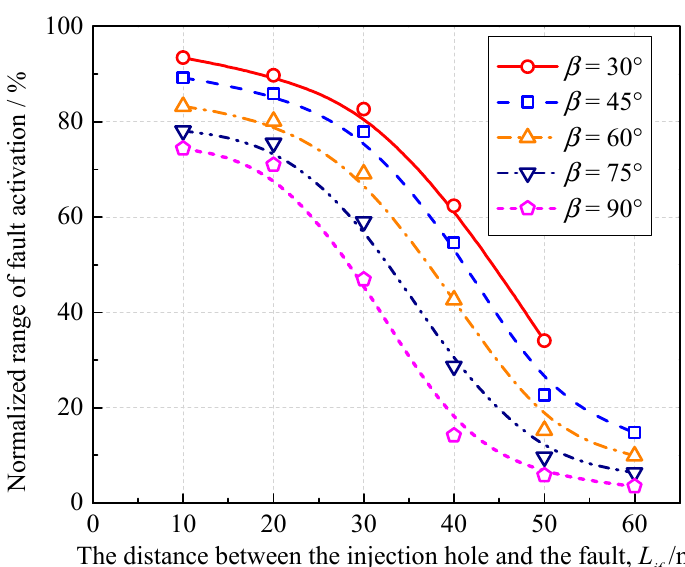
Figure 13. Change of normalized range of fault activation when the distance between the injection hole and the fault ranged from 10 to 60 m.